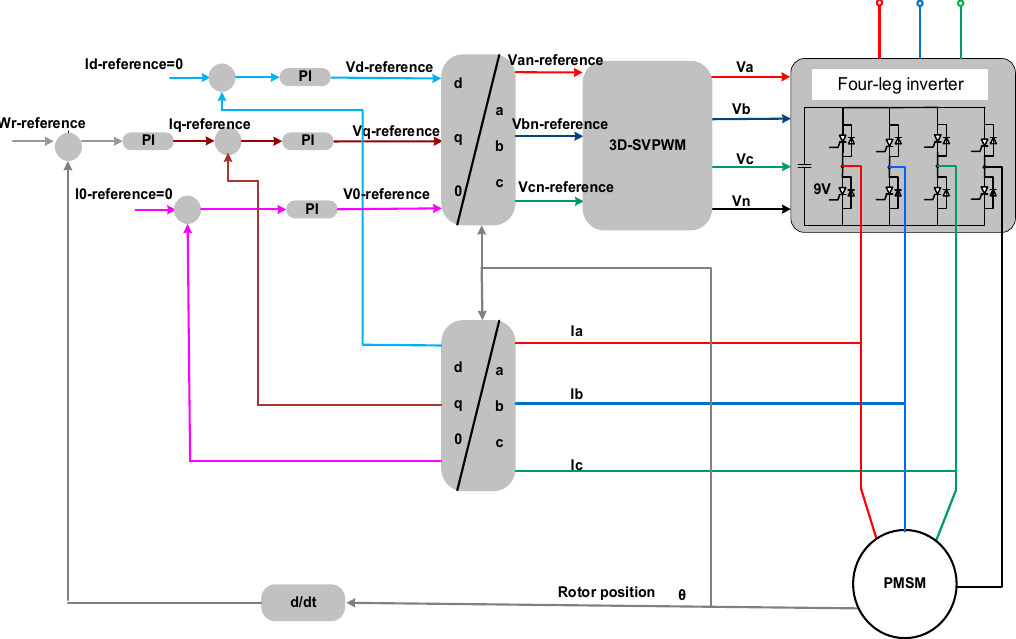
Figure 6. Closed-loop field-oriented speed control topology using 3D-SVPWM for four-leg inverter proposed in [25].